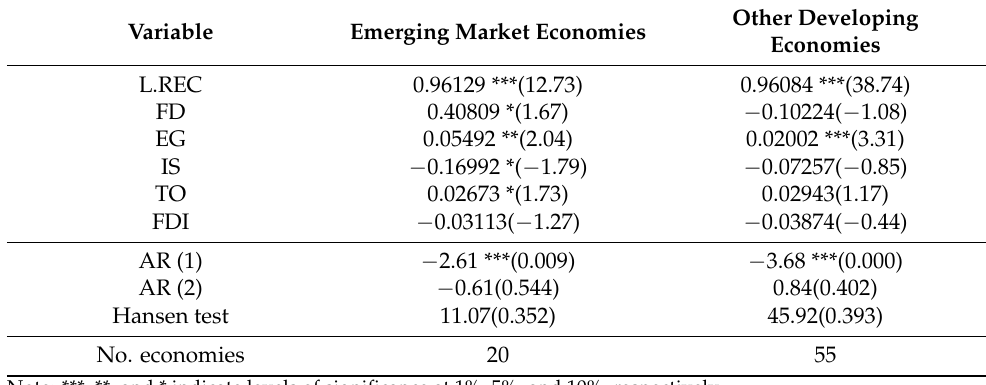
Table 6. Regression results of the first level of financial development (developing economies).